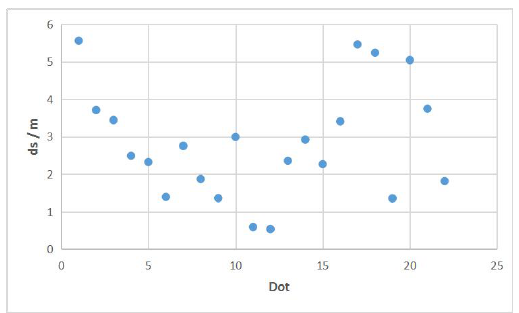
Figure 9. Errors of plane accuracy in field